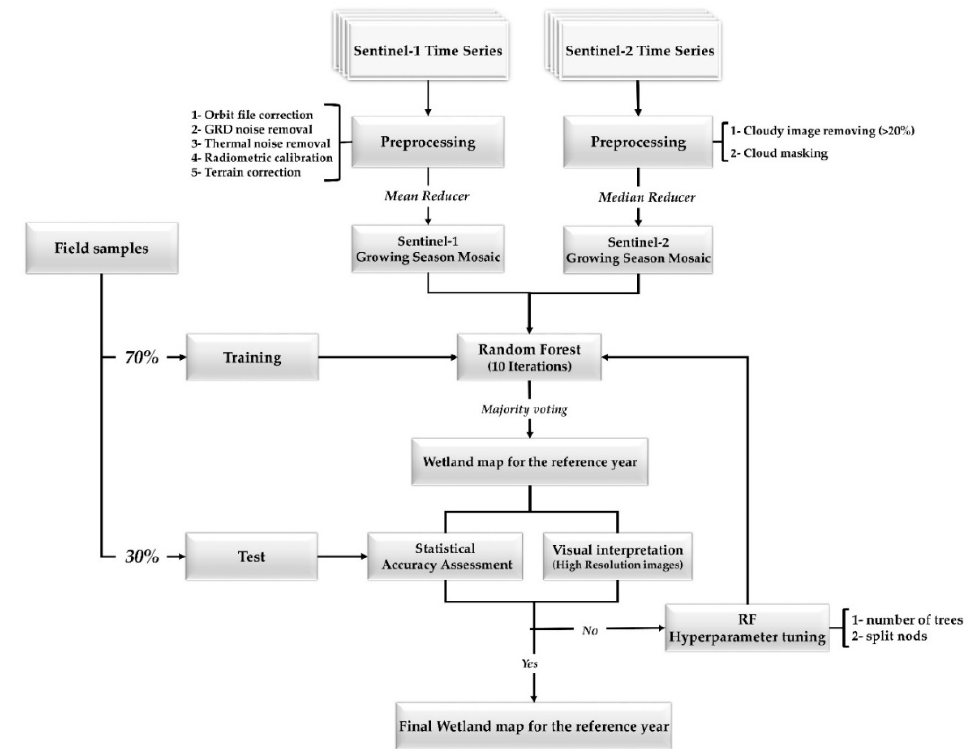
Figure 2. Workflow for wetland classification of the reference year (2020), using a combination of Sentinel-1 and Sentinel-2 images and the pixel-based Random Forest (RF) classifier within GEE.